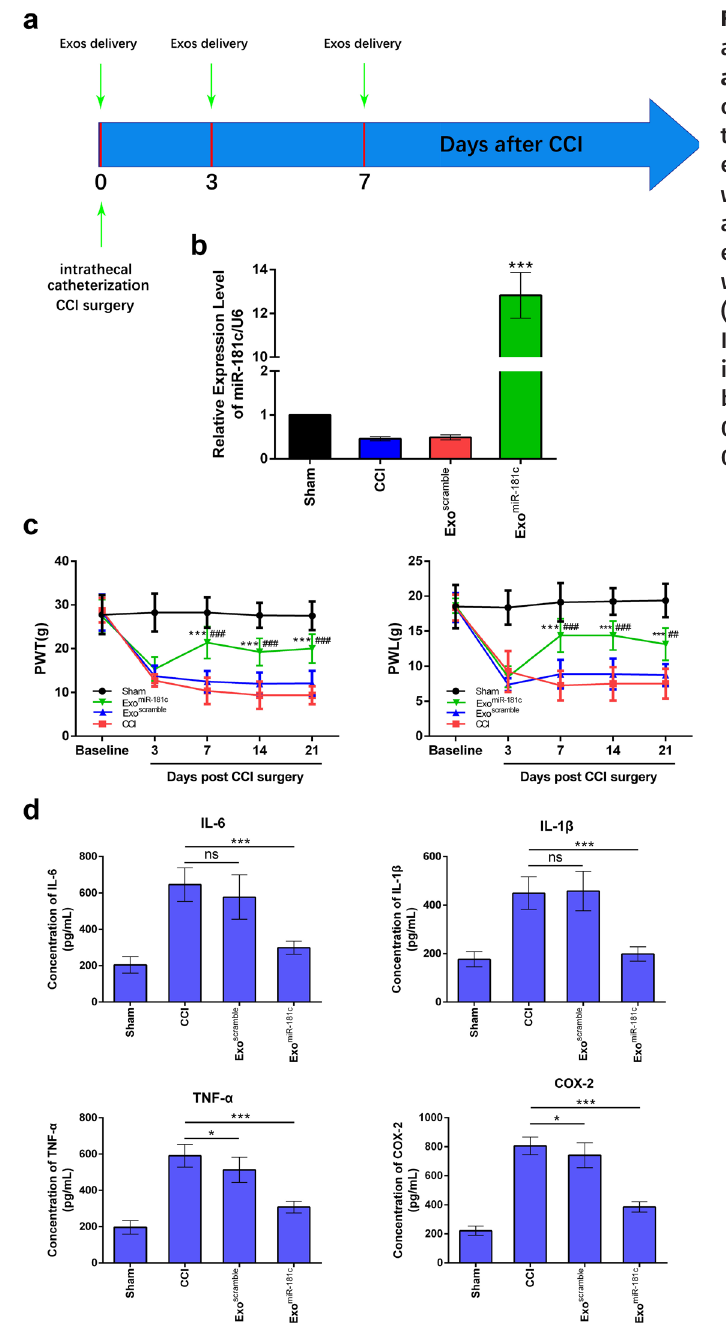
Figure 4. Exos miR-181c delivery alleviated NP in CCI rats. a. Schematic diagram of the time sequence of the experiment. b. The expression level of miR-181c was detected by RT-qPCR after Exos miR-181c . c. The effect of Exos miR-181c on NP was tested by PWT and PWL (n=12). d. Protein levels of IL-6, IL-1β, TNFα and COX-2 in spinal cord were tested by ELISA. *P< 0.05, ***P < 0.001 vs . CCI group. ### P < 0.001 vs . Exos scramble